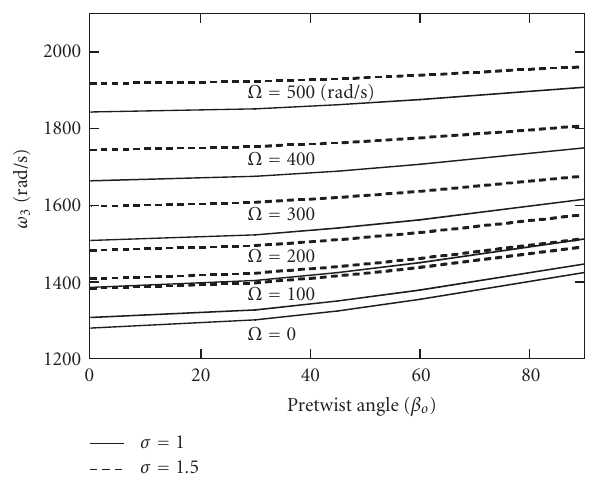
Figure 11: Variation of the second coupled frequency versus preset- ting angle for selected rotational speeds with two di ff erent ply angles ( β 0 = 45deg).